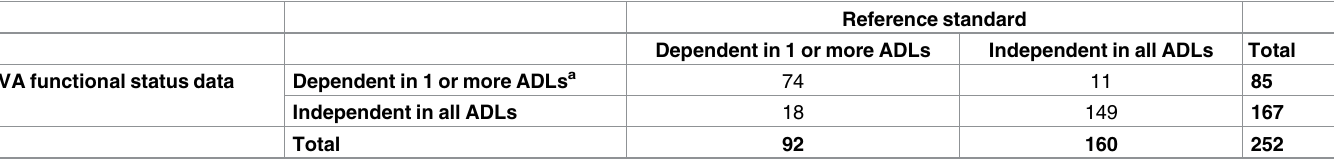
Table 3. Agreement of VA functional status data with the referencestandard of research-collected data for assessing dependence in activities of daily living.